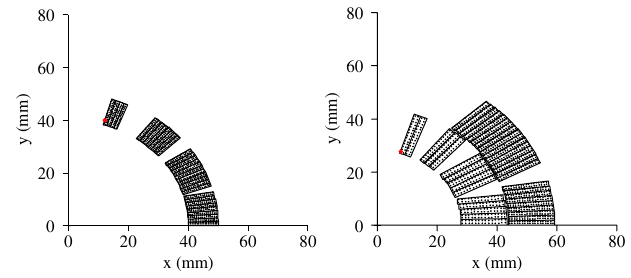
FIG. 12. Coil layout of RHIC (left) and LHC (right) dipoles.